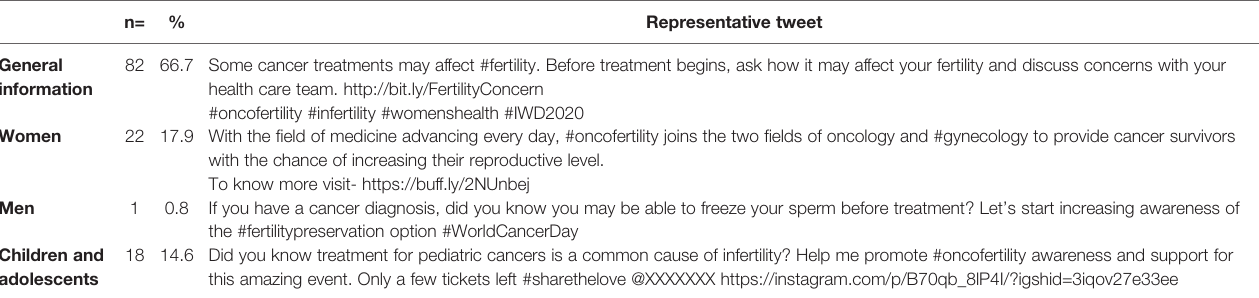
TABLE 2 | Tweets with information directed to patients and examples of tweets directed to, women, men and children and adolescents. n=